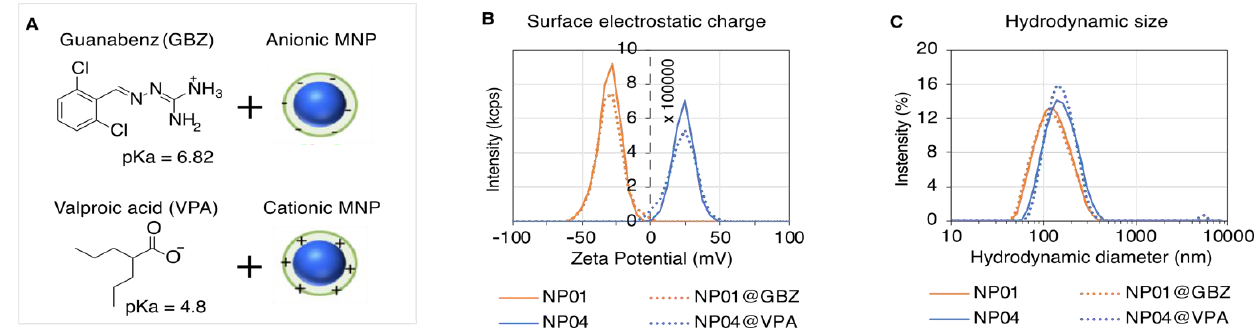
Figure 1. GBZ and VPA loading on the MNPs. ( A ) Illustration of the drug loading strategy exploiting the attractive electrostatic interaction between the ionized groups of GBA and VPA, and the charges of the opposite sign localized at the surface of anionic or cationic MNPs, respectively. Plots of the zeta potential ( B ) and hydrodynamic size ( C ) distributions of NP01 (orange plot), NP01 loaded with GBZ (orange dotted plot), NP04 (blue plot) and NP04 loaded with VPA (blue dotted plot). The zeta potentials of NP01 and NP01 loaded with GBZ (NP01@GBZ) are −29.8 ± 9.5 mV and −29 ± 10.2, respectively, whereas the zeta potentials of NP04 and NP04 loaded with VPA (NP04@VPA) are 3.0 ± 8.03 mV and 31 ± 11.3 mV respectively. The average sizes of NP01 and NP01@GBZ are 141.8 ± 64.7 nm and 146.1 ± 7.0 nm, respectively. The average sizes of NP04 and NP04@VPA are 169.7 ± 63.8 nm and 171.1 ± 61.3 nm, respectively.